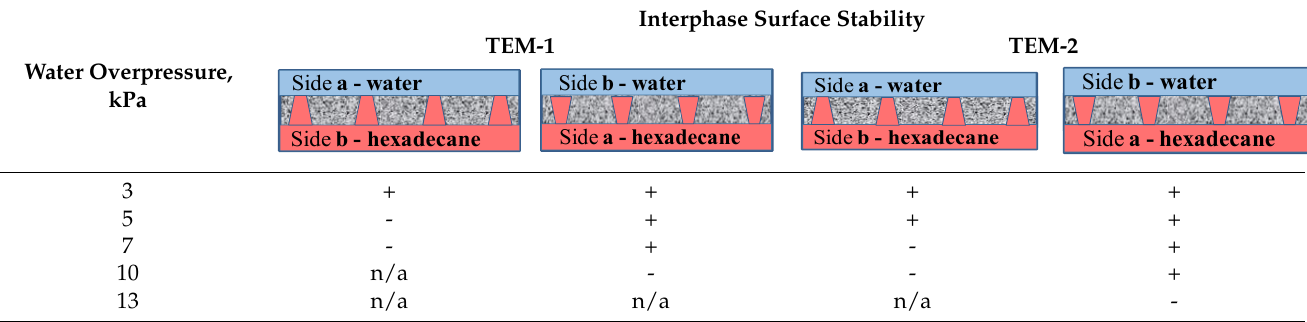
Table 5. Influence of water overpressure on the interphase stability of the “water–hexadecane” system for TEM-1 and TEM-2.